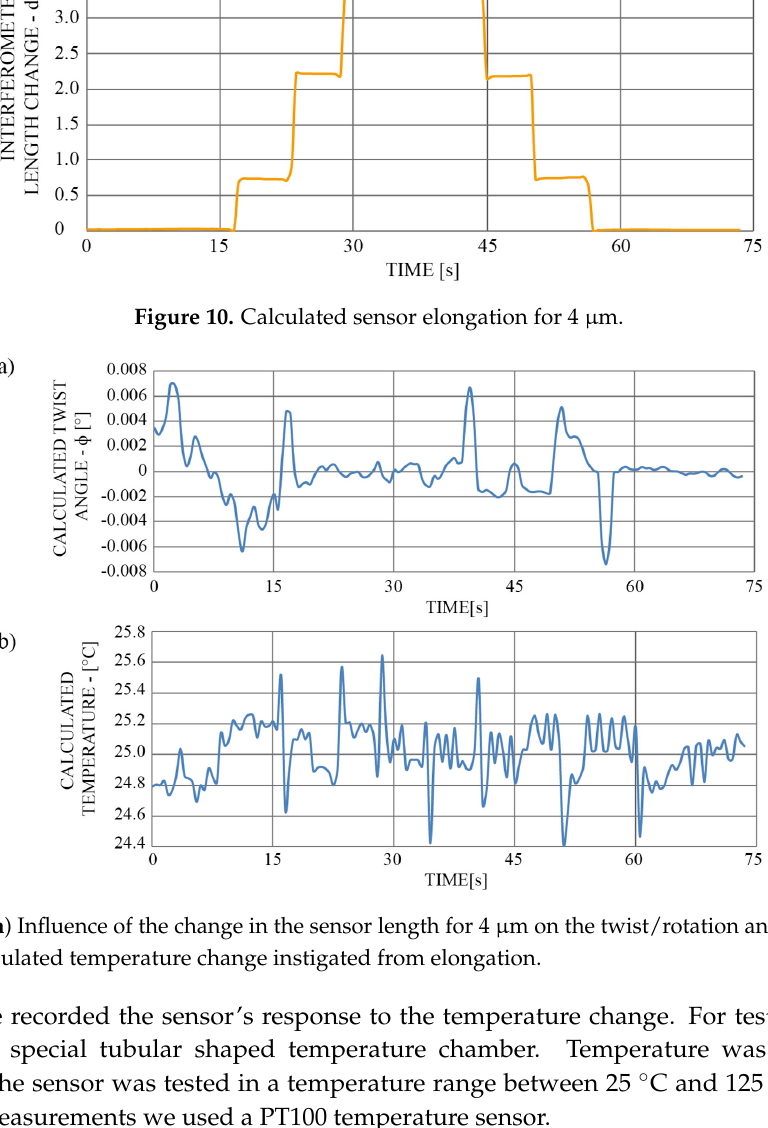
Figure 10. Calculated sensor elongation for 4 μ m.